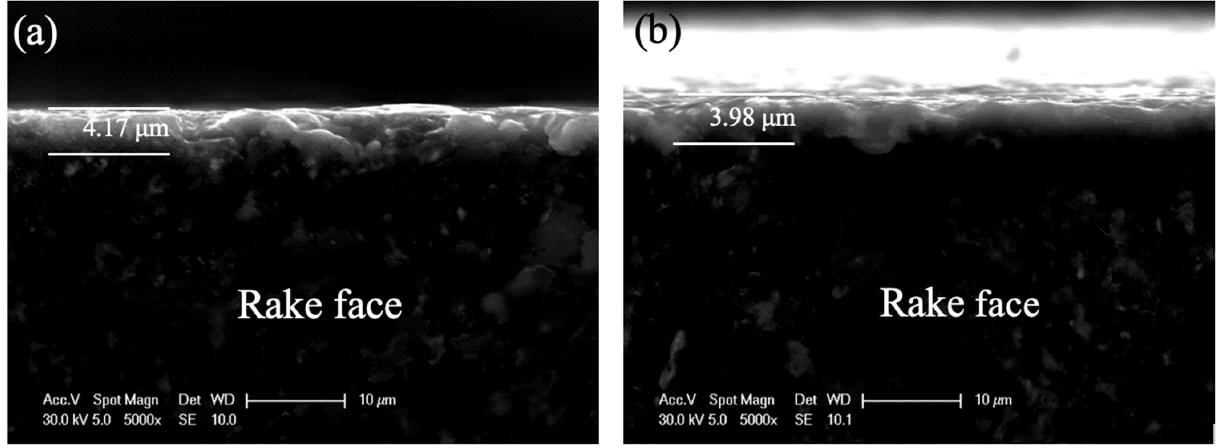
Figure 4. Side view of the reconsolidated layer on the eroded PCD inserts: ( a ) 002A ( b ) 302E. After the turning experiments, tool materials on primary flank face, secondary flank face, and rake faces were removed in the wear processes, as shown in Figure 5. A relatively intact tool tip could be found on tools 002A, 002E, and 302A. Clear triangular worn areas were found on the primary flank faces and sub flank faces because of the sharp tip of the PCD inserts. The maximum VBs of tools 002A, 002E, and 302A are 313.5 µm, 293.8 µm,